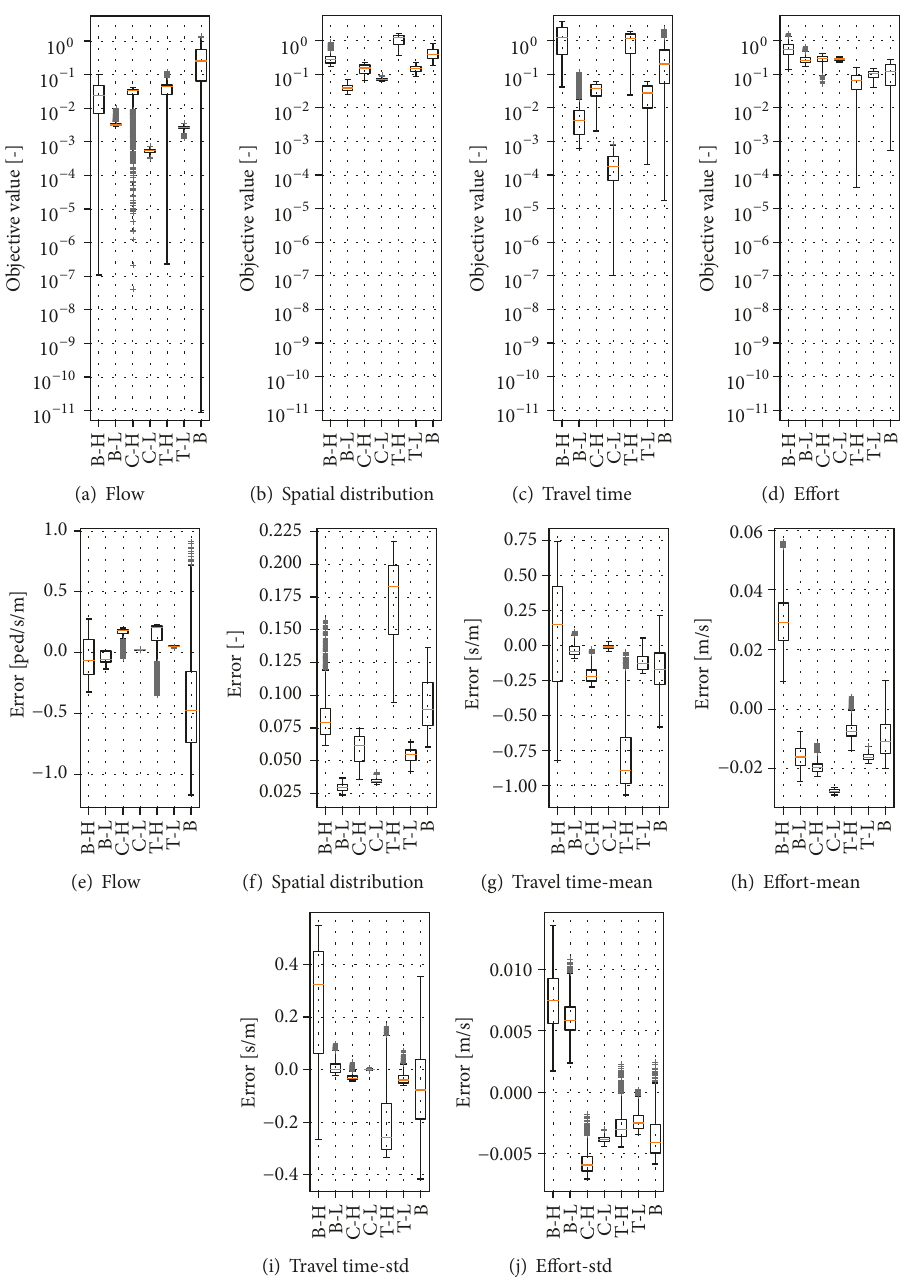
Figure 5: Results of calibrating the model using a single objective. Graphs (a)-(d) show, per combination of metric and scenario, how the objective values (calculated according to (11)) are distributed. Graphs (e)-(j) show the nonnormalized, nonsquared errors (i.e., 𝑀 sim (𝜃)−𝑀 ref ) which give insight into size and the distribution of the errors. The flow scenarios are identified by their acronyms (i.e., B-H = bidirectional high, B-L = bidirectional low, B = bottleneck, C-H = corner high, C-L = corner low, T –H = T-junction high, and T-L = T-junction